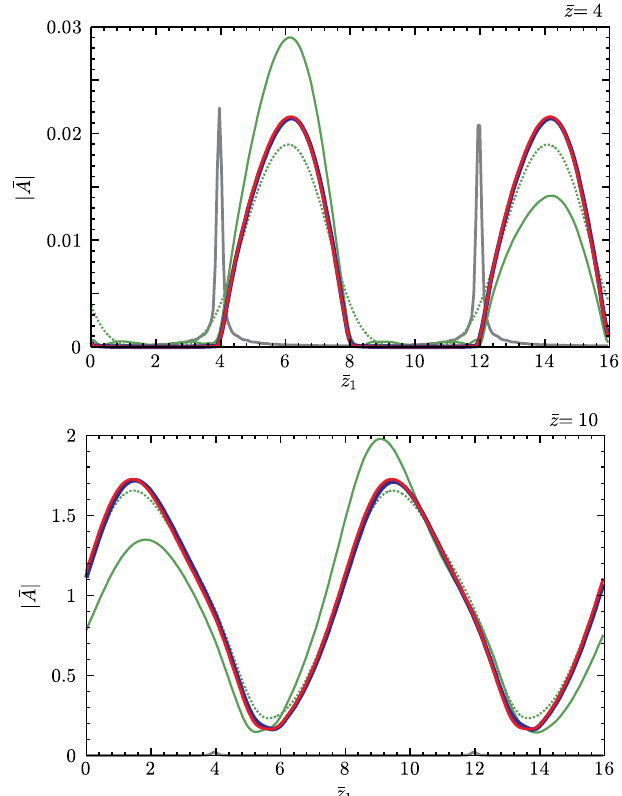
FIG. 4. Radiation output profiles versus time at (cid:3) z ¼ 4 (top) and (cid:3) z ¼ 14 (bottom) resulting from broadband HHG seeding (cf. seed spectrum in Fig. 3). The simulation window has a width of (cid:1) d ¼ 800 nm with periodic boundary conditions. The grey line repre- sents the initial seed profile, with the characteristic two spikes per driving laser wavelength—this seed profile has been subtracted from the other results, leaving only radiation generated during FEL gain. Non-SVEA AURORA results are in blue while SVEA code results using a seed filtered with a Gaussian of rms width ! 0 = 2 (cid:3) are in red. The solid (dotted) green line represents SVEA simulation results where the input seed was filtered with a 1 : 67 (cid:6) broader ð 10 (cid:6) narrower Þ Gaussian